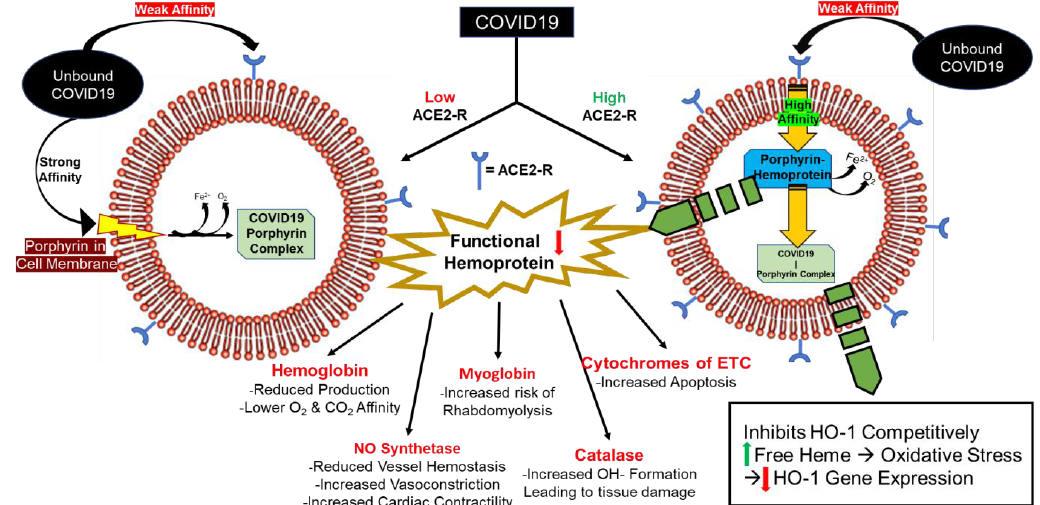
Figure 2. COVID-19 infects the cells. COVID-19 increases free heme and free iron (Fe), but more importantly, decreases functional hemoprotein. (Left) Unbound COVID-19 binds to porphyrin within the cell membrane with high affinity, providing entry into the cell. Iron and oxygen are released forming a COVID-19-Porphyrin complex. The COVID-19-porphyrin complex competitively inhibits heme oxygenase (HO-1) leading to severe oxidative stress from free heme and iron, and subsequently downregulates HO-1 gene expression. (Right) Unbound COVID-19 binds ACE-2 receptor with lower affinity than porphyrin, and upon internalization into the cell, binds to the porphyrin substrate of hemoprotein within the cell. The result is a malfunctional hemoprotein, and with the release of iron and oxygen, a COVID-19-porphyrin complex. The consequences of increased free heme and iron along with decreased HO-1 levels, inhibition of HO-1, and decreased functional hemoprotein levels have detrimental effects to the infected cells. Key: oxygen = O 2 , carbon dioxide = CO 2 , electron transport chain = ETC, hydroxide = OH − .